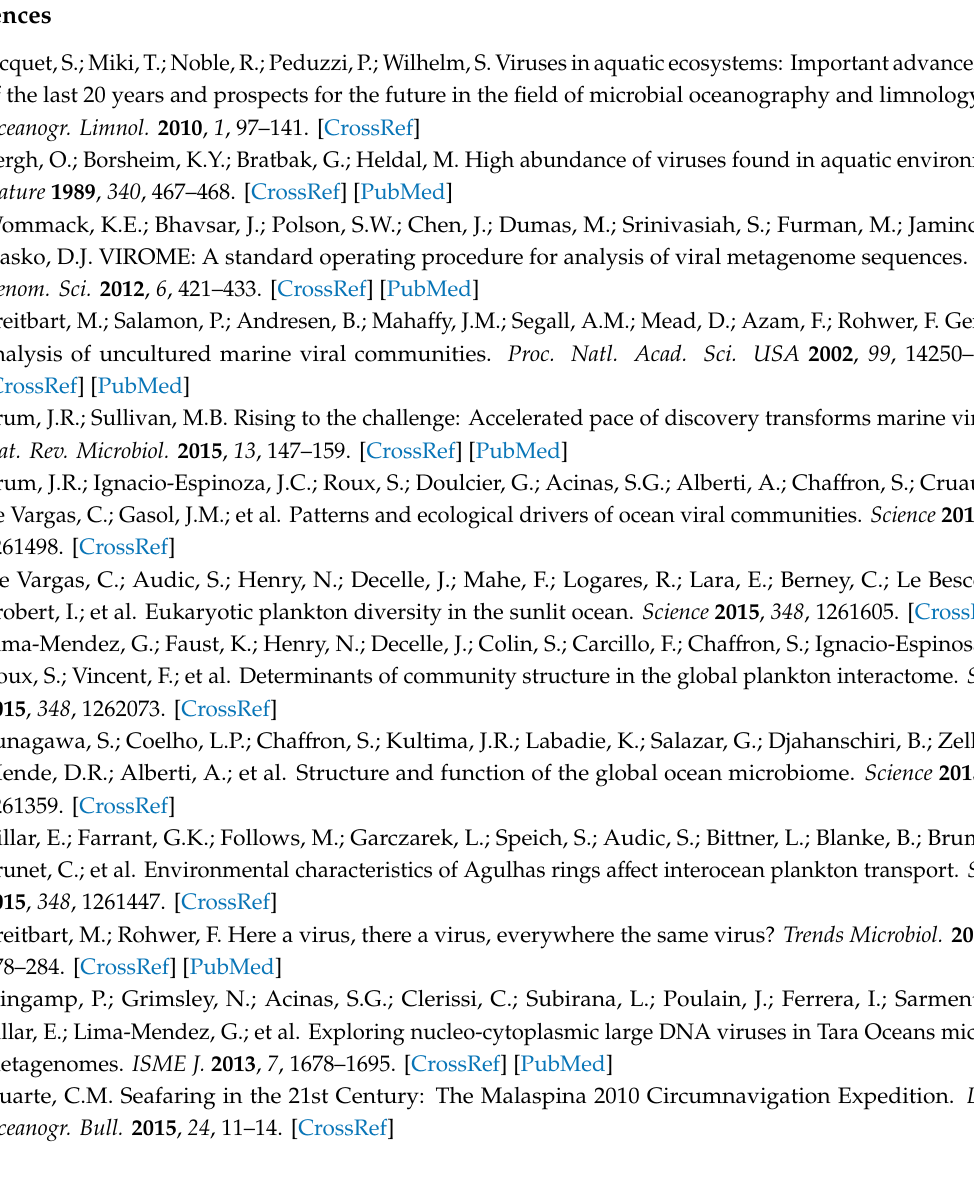
Table S1: List of original taxonomic annotations and reassigned taxonomic a ffi liations of virus contigs in Hamilton Harbour